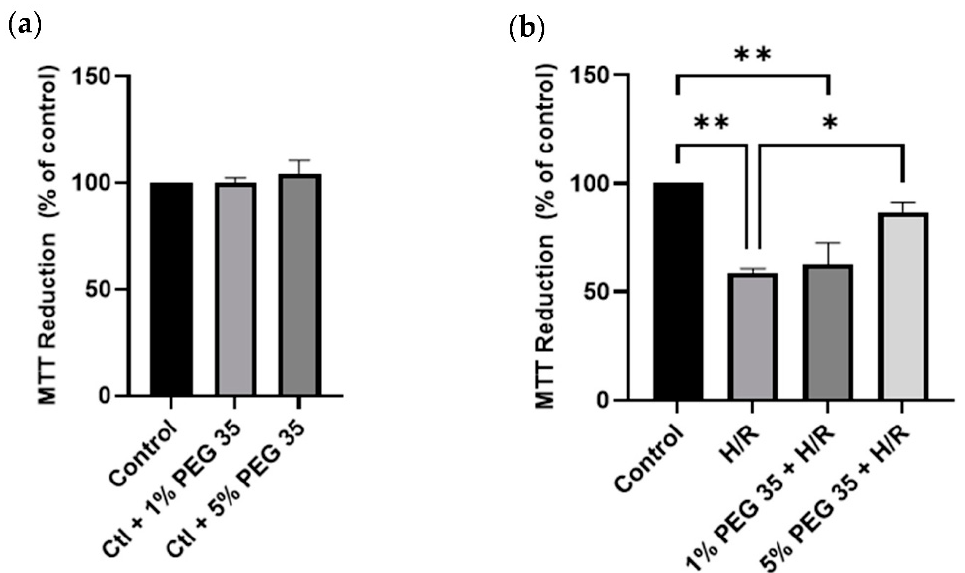
Figure 1. Effects of PEG35 on cell viability, in the absence ( a ) or presence ( b ) of hypoxia/reoxygenation (H/R). Cell viability rate determined via MTT assay. The values shown represent the mean ± SEM of 3 independent experiments. * p < 0.05; ** p < 0.01.